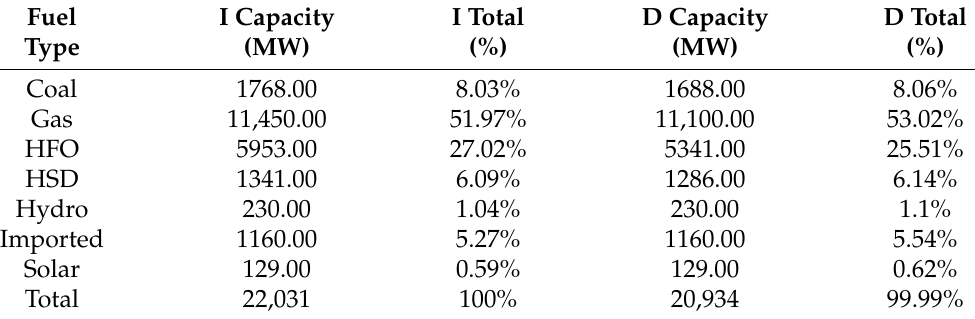
Table 1. Installed (I) and derated (D) capacities of BPDB power plants